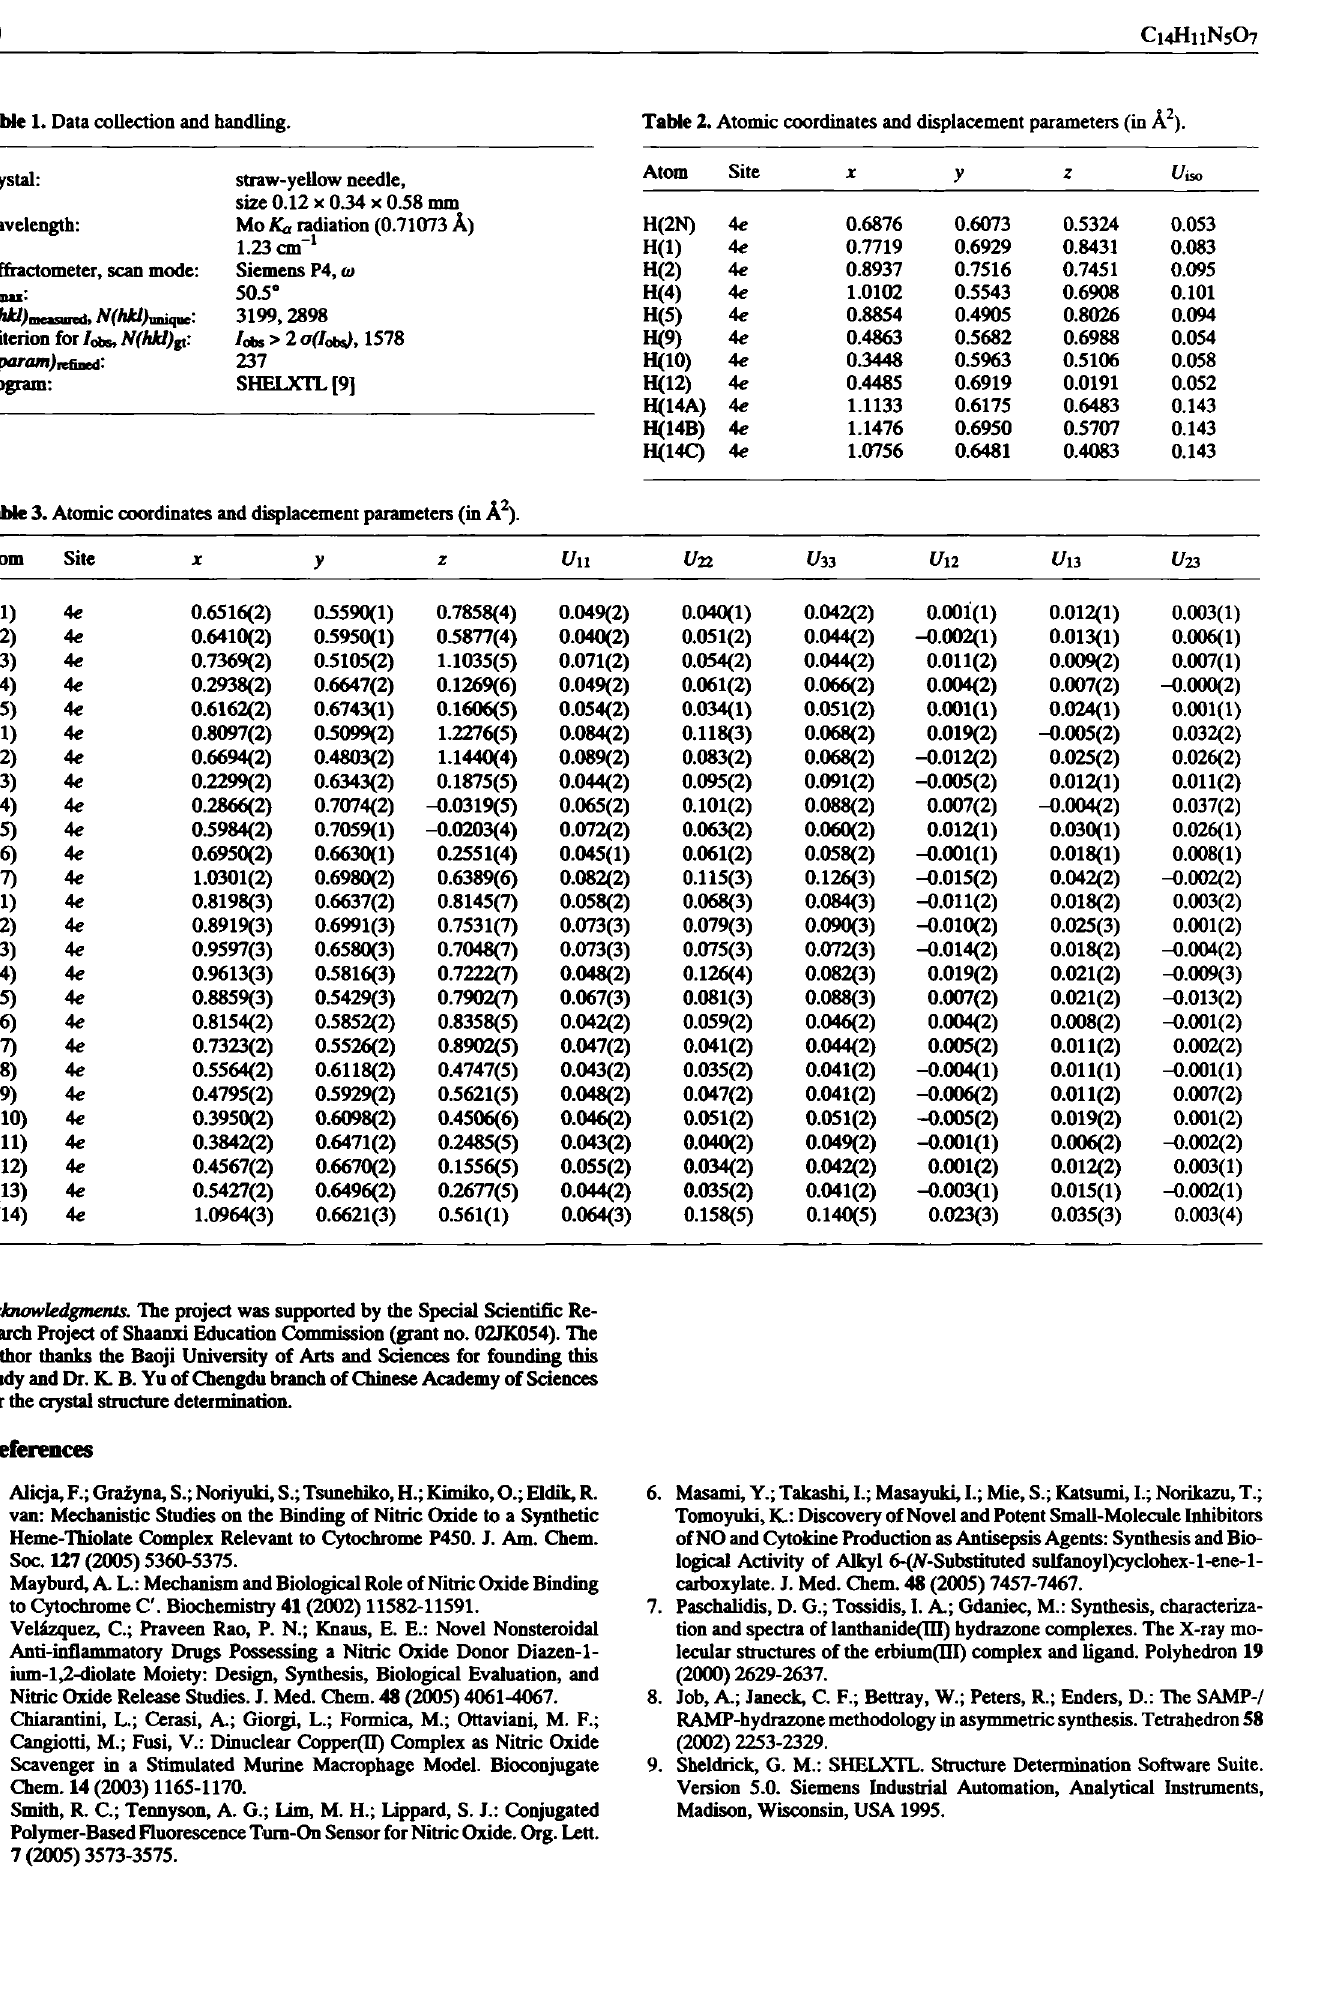
Table 1. Data collection and handling. Table 2. Atomic coordinates and displacement parameter (in Ä 2 ).